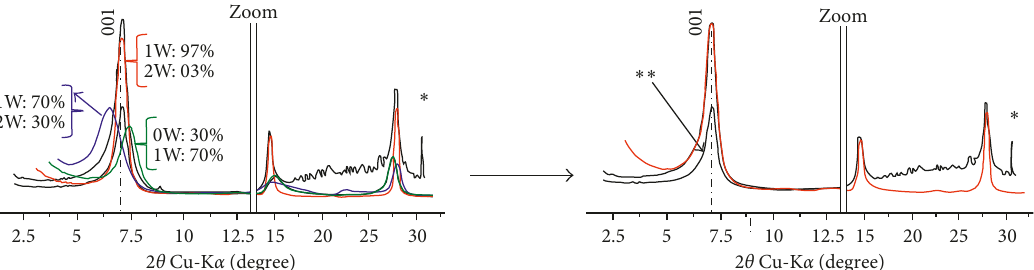
Figure 1: Example of an experimental XRD profile modeled using three MLSs containing (97%-1W, 3%-2W), (30%-0W, 70%-1W), and (70%-1W, 30%-2W), respectively.